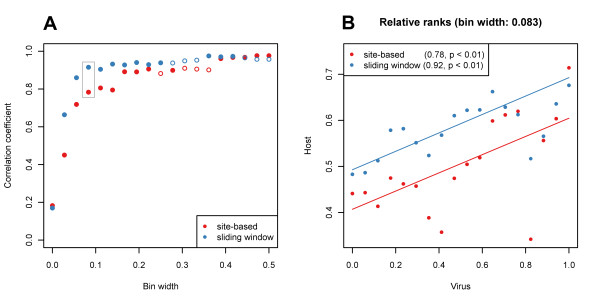
Correlation of the normalized ranks of the interacting host and viral proteins obtained from site-based and sliding window scoring of the host genes and relative evolutionary rates of the viral genes in the comparison of the all four primate species and the alignment of all viruses. (A) Correlation coefficients of the ranks of interacting proteins averaged by bin size. Significant correlation coefficients (p ≤ 0.05) are indicated by filled dots, the gray box indicates correlation coefficients of ranks plotted in panel B. (B) Plot of viral and host binned ranks. The correlation coefficients obtained for each host gene scoring is indicated in the brackets, lines are fitted according to least sum of squares.